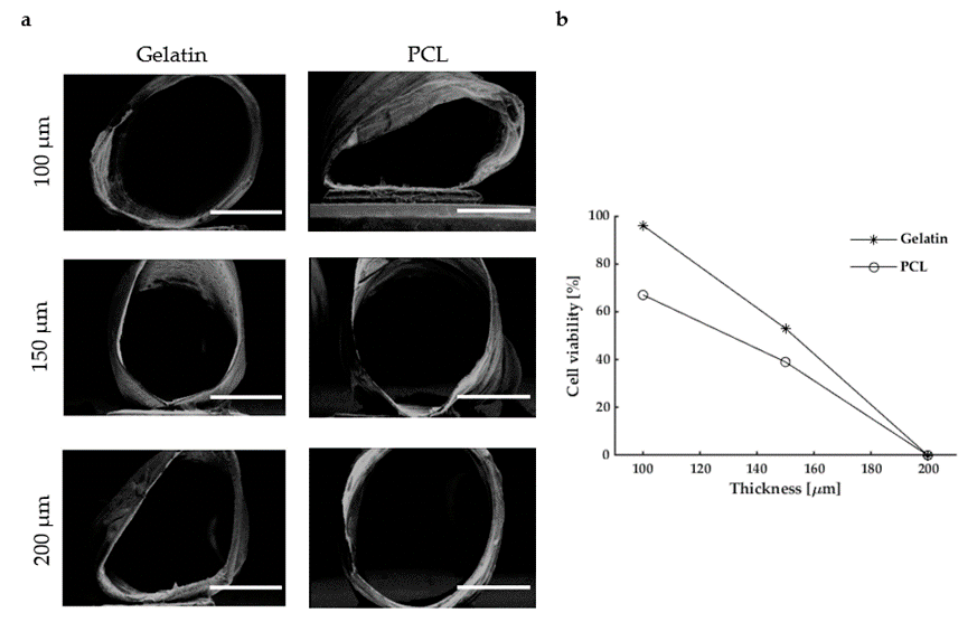
Figure 4. Evaluation of NGC thickness: ( a ) SEM micrographs of electrospun PCL and gelatin guides with different thicknesses. Scale bar 10 µ m; ( b ) cell viability vs. thickness for gelatin and PCL guides.